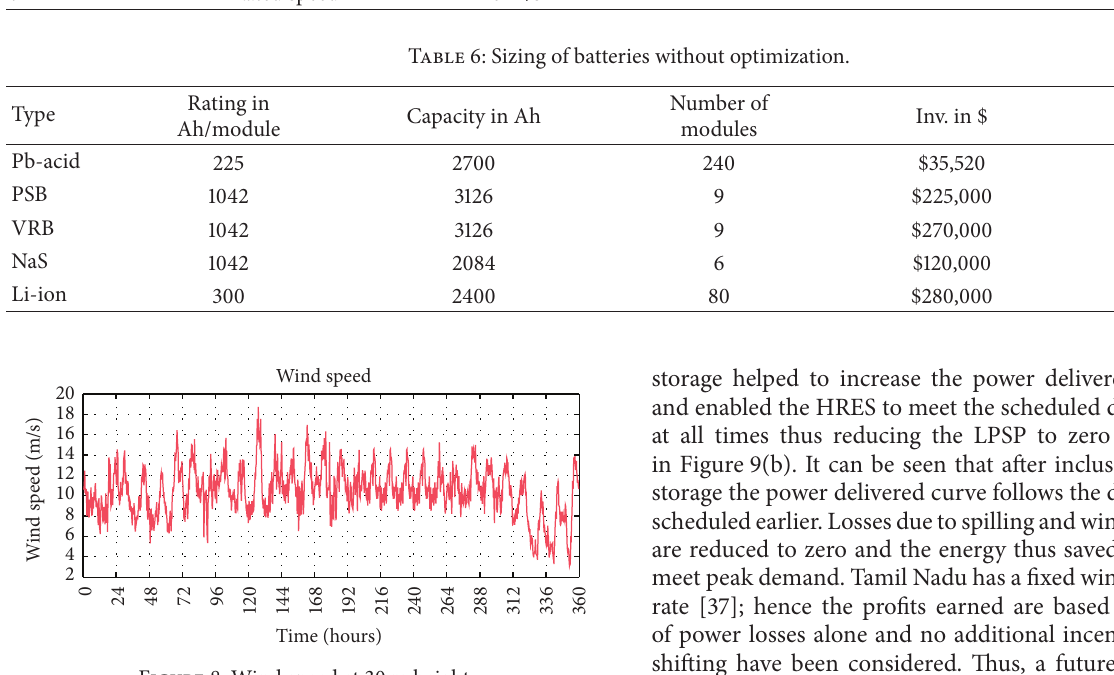
Figure 8: Wind speed at 30 m